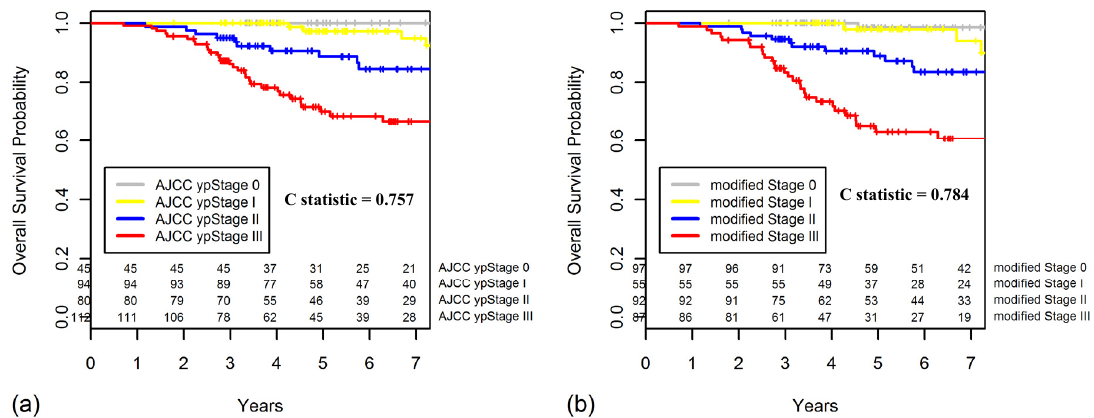
Figure 6. Kaplan-Meier curves for OS comparing ( a ) the AJCC ypStaging and ( b ) the new modified staging system.